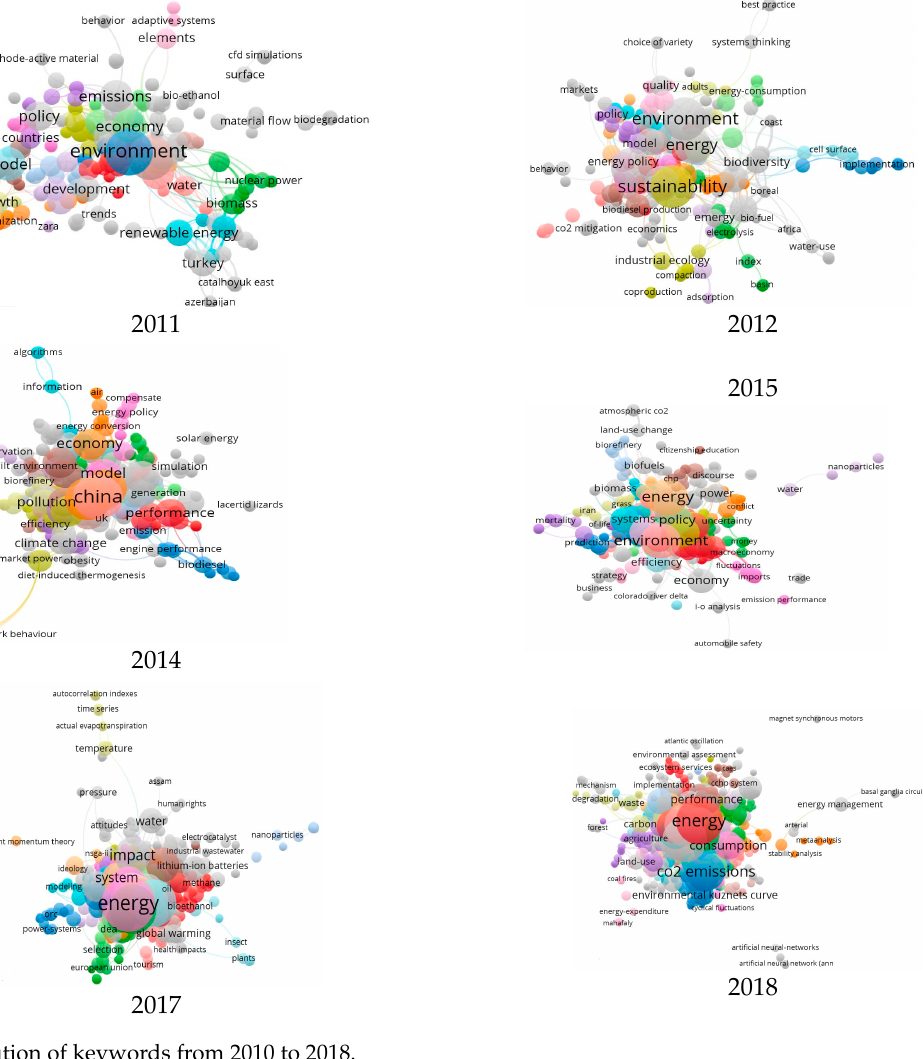
Figure 6. Evolution of keywords from 2010 to 2018.